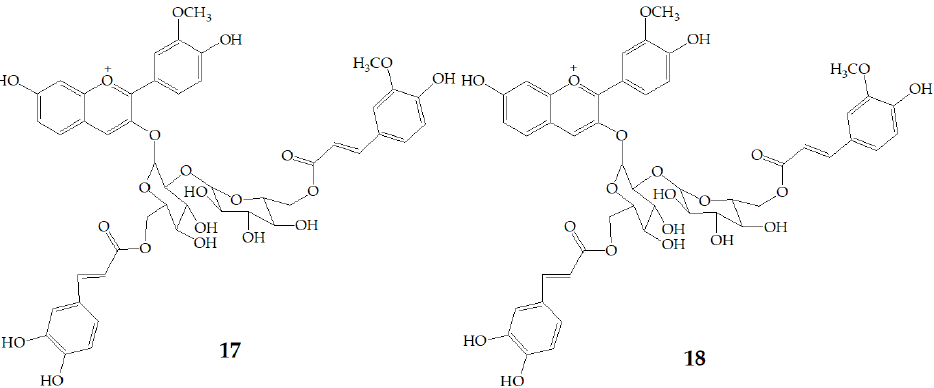
Figure 3. Chemical structures of compound 15 – 18 .